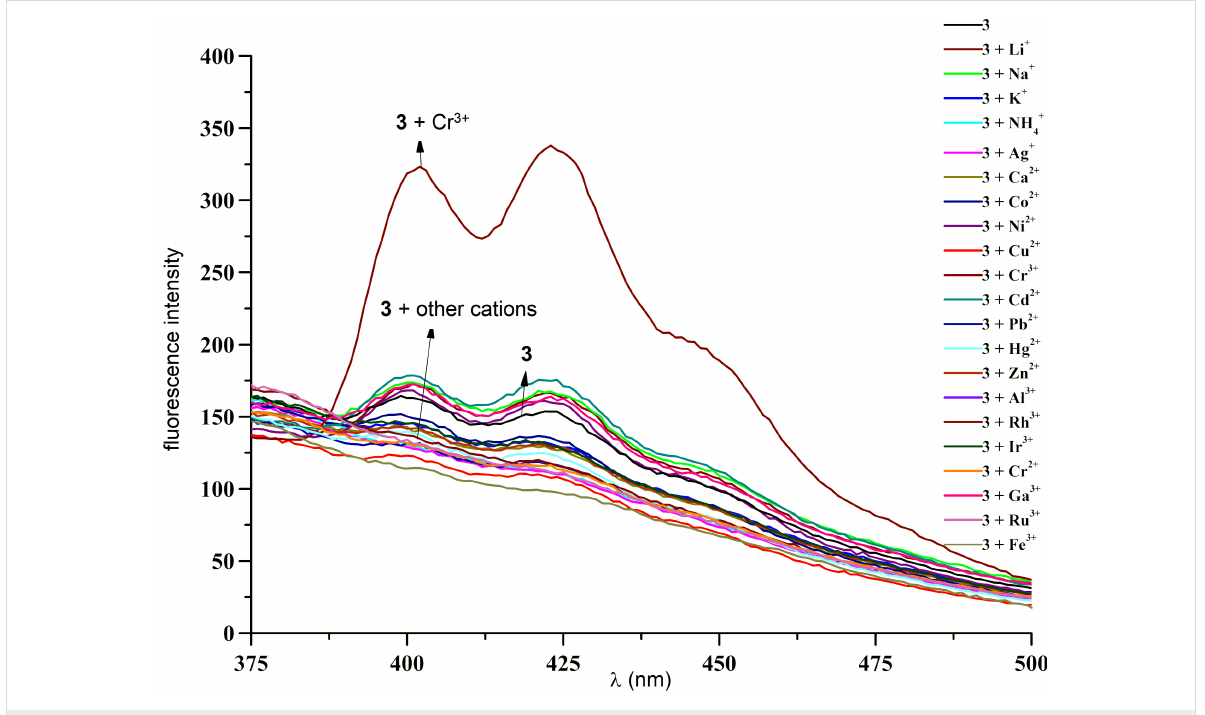
Figure 2: Fluorescence spectra of 3 ( c = 5.0 ⋅ 10 − 6 M) upon addition of 30 equiv of salts of K + , Na + , Li + , Ag + , NH 4 + , Zn 2+ , Cd 2+ , Ca 2+ , Ni 2+ , Pb 2+ , Cu 2+ , Co 2+ , Al 3+ , Cr 3+ , Hg + , Hg 2+ , Rh 3+ , Ir 3+ , Cr 2+ , Ga 3+ , Ru 3+ , and Fe 3+ , respectively ( c = 1.5 ⋅ 10 − 4 M) in CH 3 CN/DMSO, 9:1, v/v at room temperature (ex- citation wavelength λ ex = 258 nm).